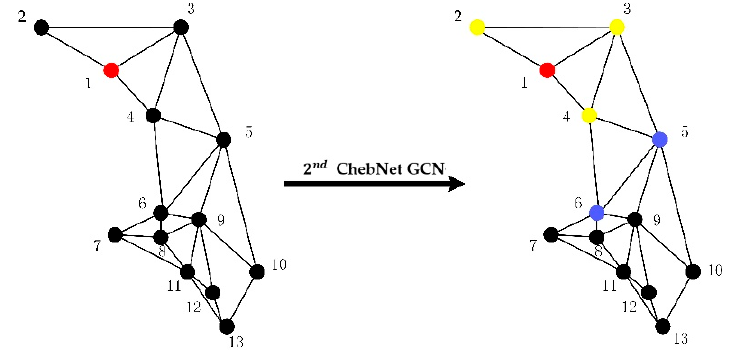
9 of 19 Figure 3. First-order GCN implementation process.